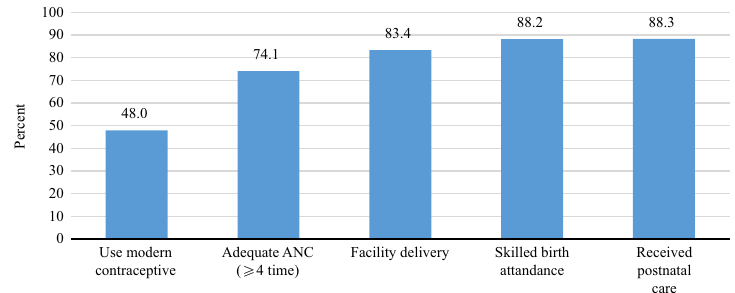
women ’ s use of reproductive and maternal health services by